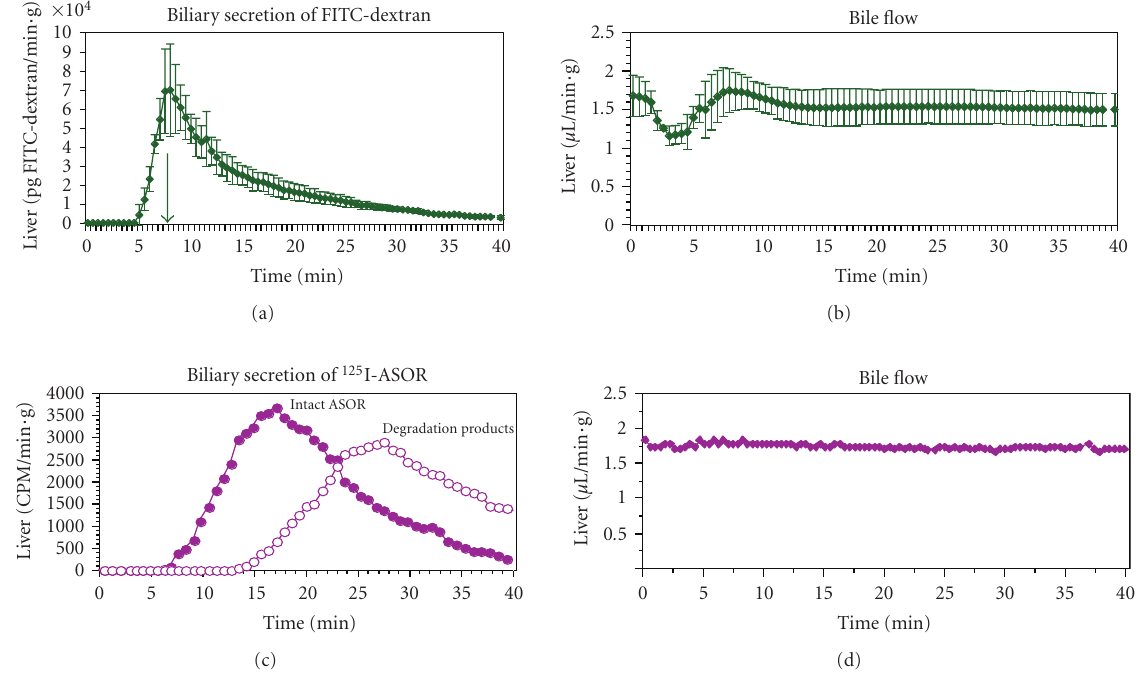
Figure 1: Kinetics of biliary secretion of FITC-dextran (a) and ASOR (c). Livers were isolated and following 30-minute perfusion, FITC- dextran (5mg/mL) or 125 I-ASOR was administered in the perfusion medium (KHB) for 1 minute and 2 minutes, respectively, at 37 ◦ C (time 0) followed by a single-pass perfusion with marker-free KHB at 37 ◦ C. (a) Single bile drops were collected and the FITC-dextran concentration was determined using a calibration curve. Data were converted into secretion (ng FITC-dextran/min and g liver). In (b) the corresponding bile flow is shown (mean ± SD from two (a, b) perfusions). (c) Single bile drop were subjected to precipitation with 10% TCA. Secretion of intact ASOR (TCA precipitable counts) and degradation products (TCA soluble counts) of one typical experiment out of six are shown. (d) Corresponding bile